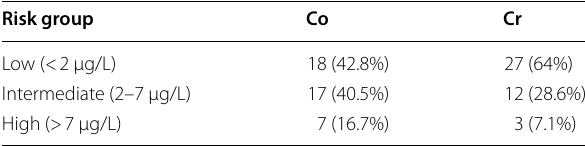
Table 3 Number of patients and percentage in each risk group for Co and Cr whole blood